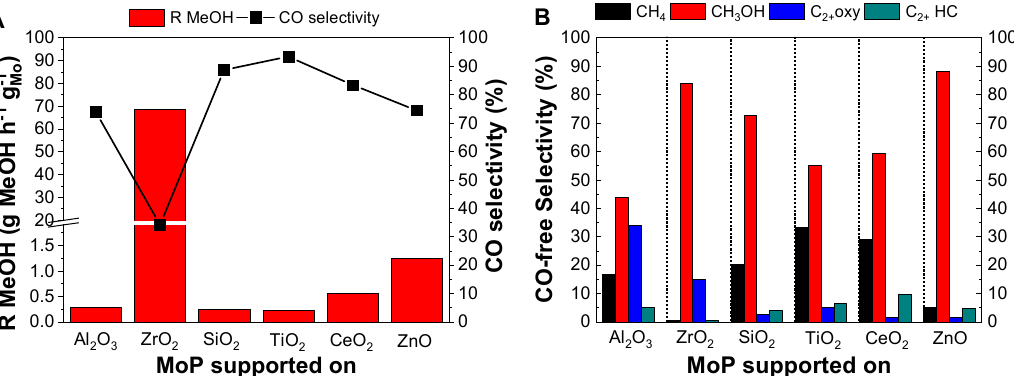
Figure 5. ( A ) CO selectivity and normalized activity of supported MoP catalysts ( B ) CO-free selectivity of supported MoP catalysts. Test conditions: CO 2 hydrogenation, 40 bar, 250 °C, H 2 /CO 2 = 3, Conversion = 0.3–1.8%.